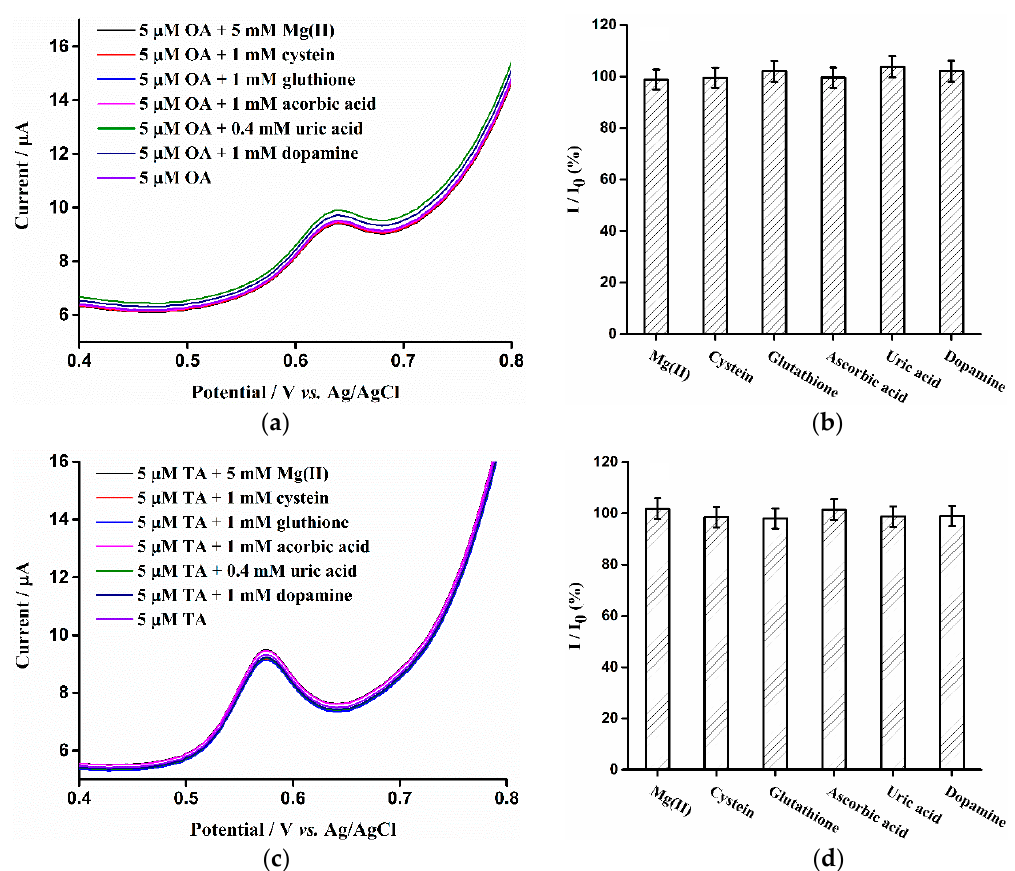
Figure 8. ( a , c ): DPV of ERGO/GCE in in 0.1 M phosphate buffer solution (pH 7.0) containing 5 μ M (OA) ( a ) and 5 μ M (TA) ( c ) in the presence of interferents (5 mM·Mg (II), 1 mM cysteine, ascorbic acid, dopamine and glutathione, and 0.4 mM uric acid). The DPV parameters of OA and TA are the same as Figure 3c,d, respectively; ( b , d ): The effect of interferents on the DPV anodic peak current of OA ( b ) and TA ( d ). I and I 0 represent the DPV anodic peak current before and after the addition of interferent, respectively.